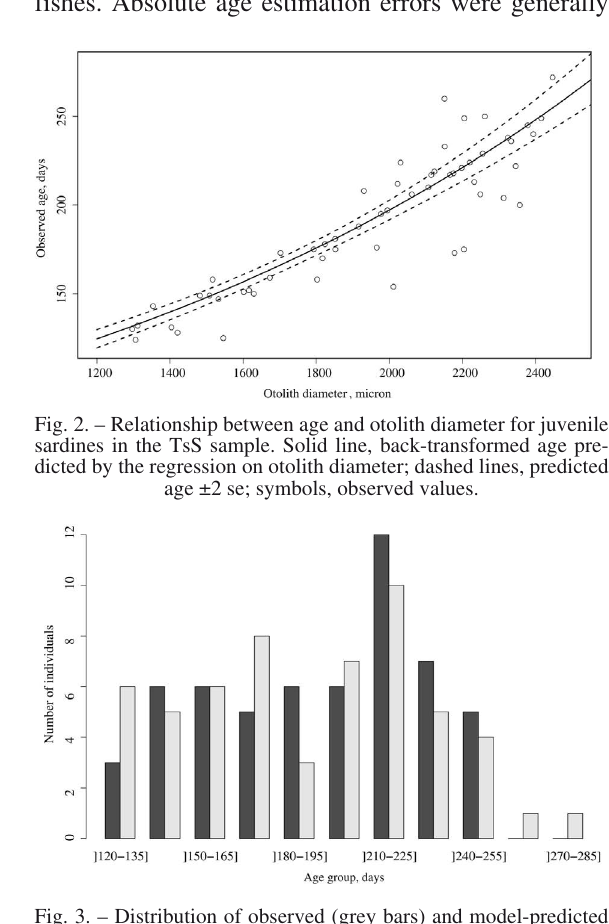
Fig. 3. – Distribution of observed (grey bars) and model-predicted (black bars) ages of sardine juveniles in the test